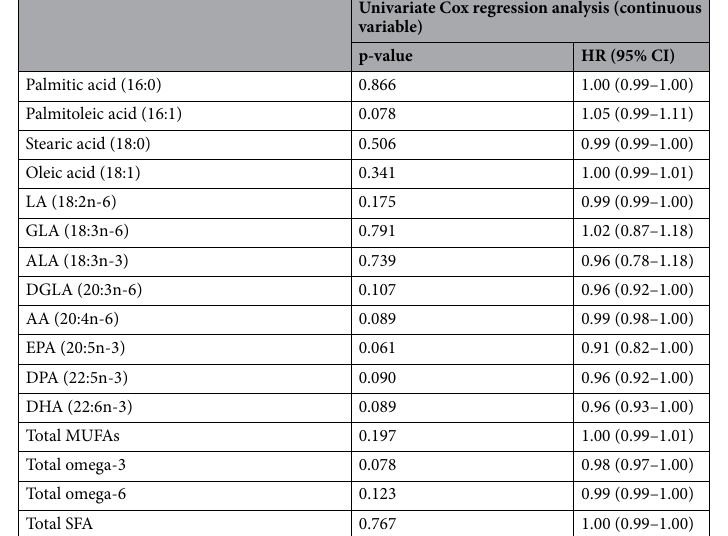
Table 2. Univariate Cox regression analysis for each fatty acid contained in skeletal muscle phospholipid. HR are derived from univariate analysis adjusted by sex. Fatty acids with p-value < 0.1 were selected for Cox regression analysis (categorical variable) to determine threshold values of fatty acids content that best separates patients risk with respect to survival. ALA alpha linolenic acid, AA arachidonic acid, DGLA Dihomo-gamma- linolenic acid, DHA Docosahexaenoic acid, EPA Eicosapentaenoic acid, GLA gamma linolenic acid, LA linoleic acid, MUFA Monounsaturated fatty acids, SFA Saturated fatty acids.